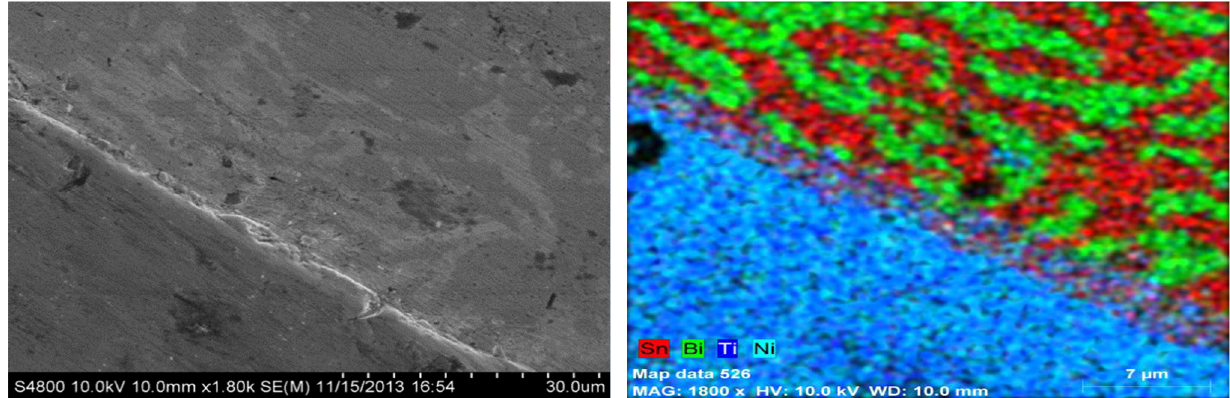
Figure 3. X-ray Spectrographic scan across the material interface. Reprinted/adapted with from Ref. [20]. 2013, Shobhit Misra.permission